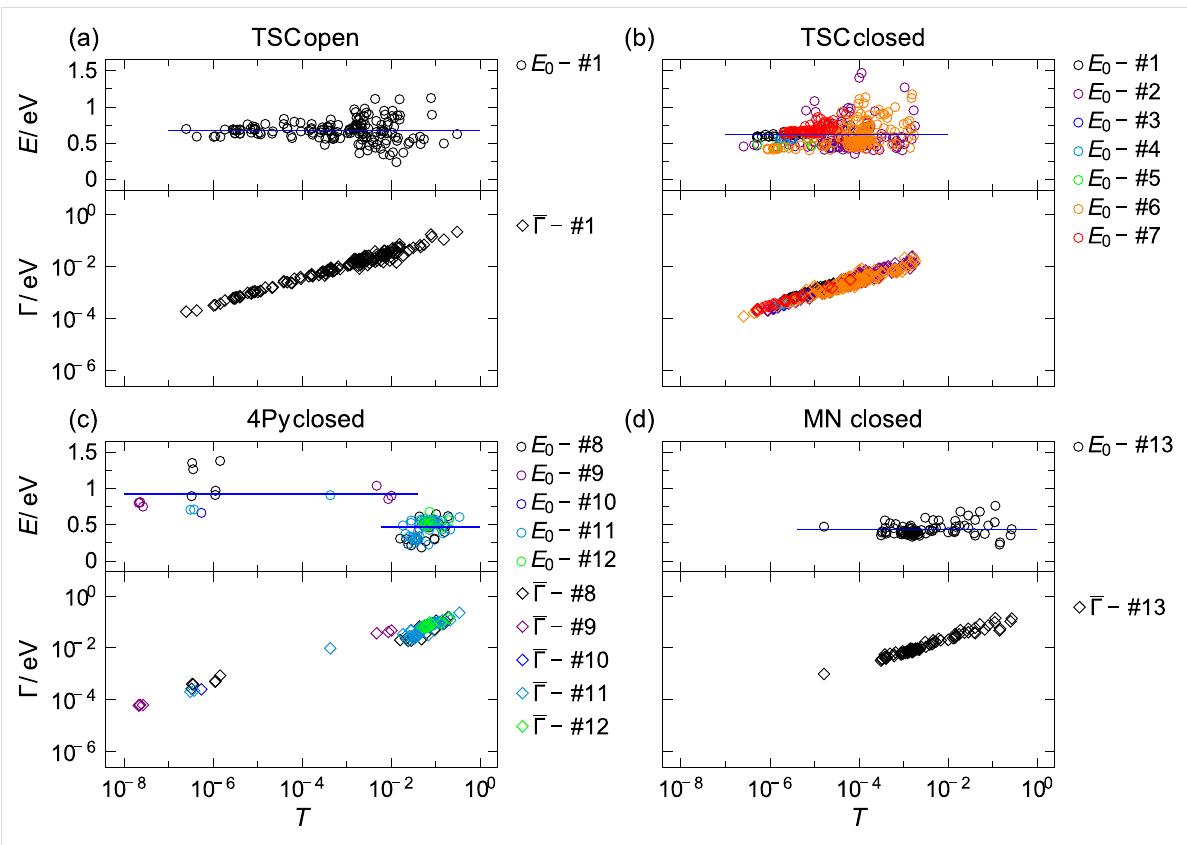
Figure 4: Fitting parameters Γ and | E 0 | for (a) open form of TSC, (b) closed form of TSC, (c) closed form of 4Py, and (d) closed form of MN as a func- tion of the transmission for symmetric I – V ’s. The various colors in panels (b) and (c) refer to the individual samples used for recording the data. We define those I – V ’s as “symmetric” for which the ratio of Γ L to Γ R is between 0.5 and